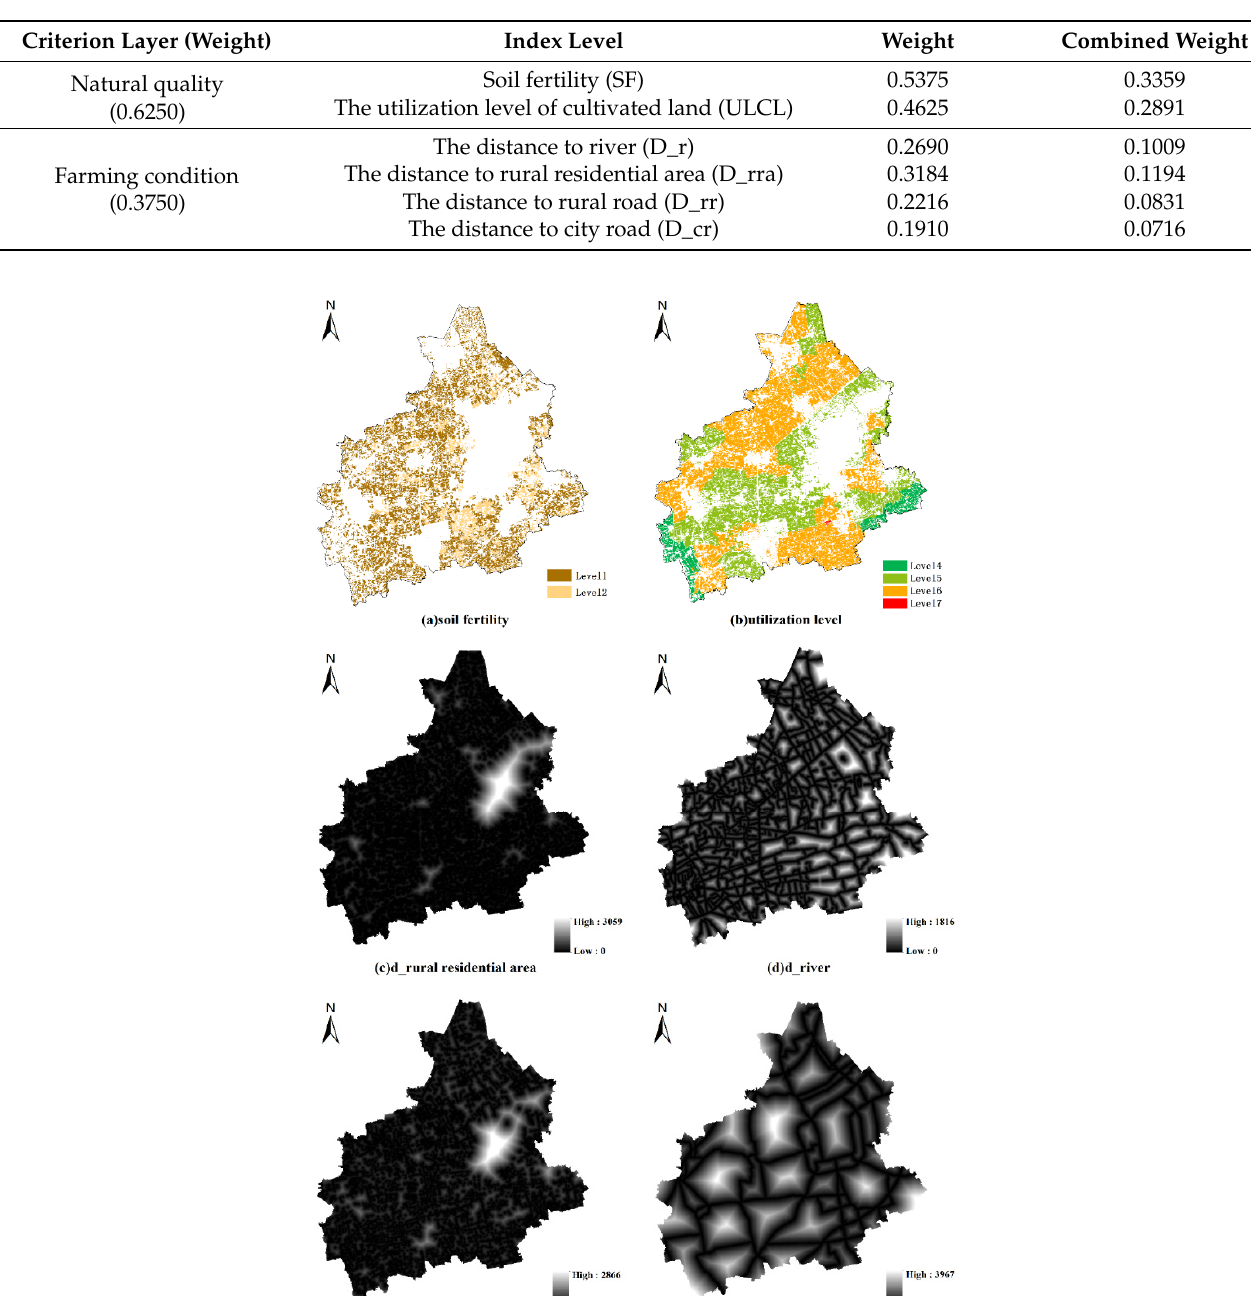
Table 2. Index system and weight of comprehensive evaluation of cultivated land production function in Tongxiang.